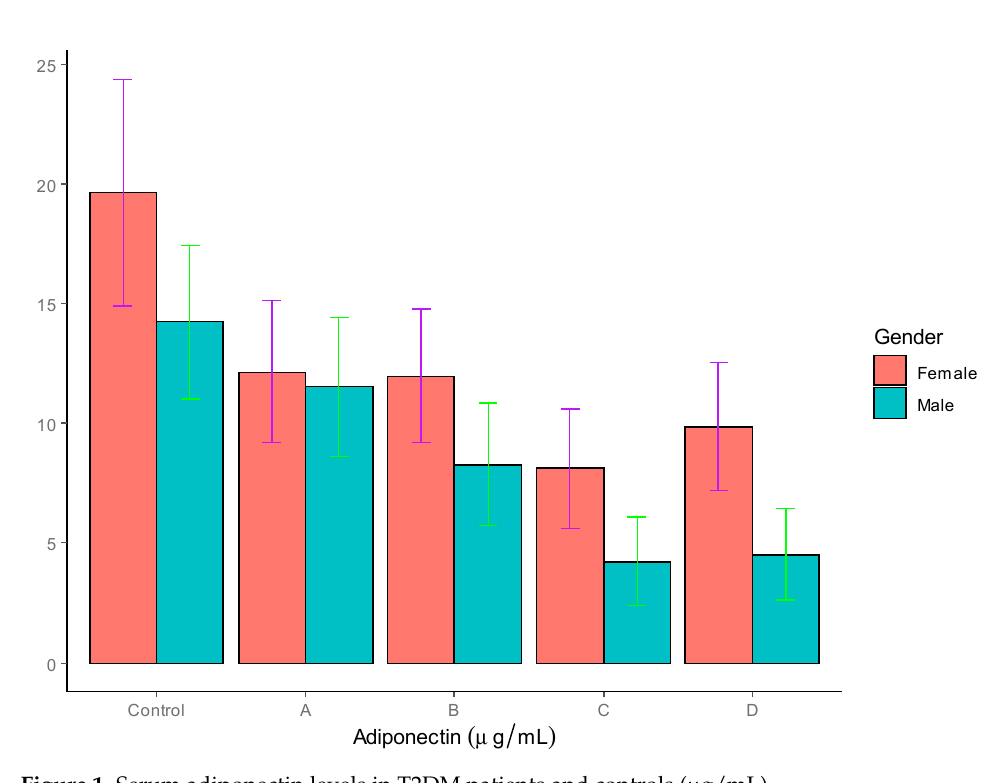
Figure 1. Serum adiponectin levels in T2DM patients and controls (µg/mL). Leptin: In the control group, the leptin levels were found to be significantly higher in the females (25.42 ± 5.78 * ng/mL) compared to the males (5.42 ± 1.98 ng/mL) p < 0.001). In the women, the plasma leptin concentrations were significantly increased in the group D patients with severe obesity compared to the controls. However, the men with T2DM with obesity in group C presented significantly high levels of leptin compared to the controls and groups A and B, with p < 0.01, whereas the men with T2DM in group D with severe obesity demonstrated significantly high levels of adiponectin compared to the controls and groups A and B, with p < 0.001. The leptin levels are summarized in Table 1 and graphically depicted in Figure 2.